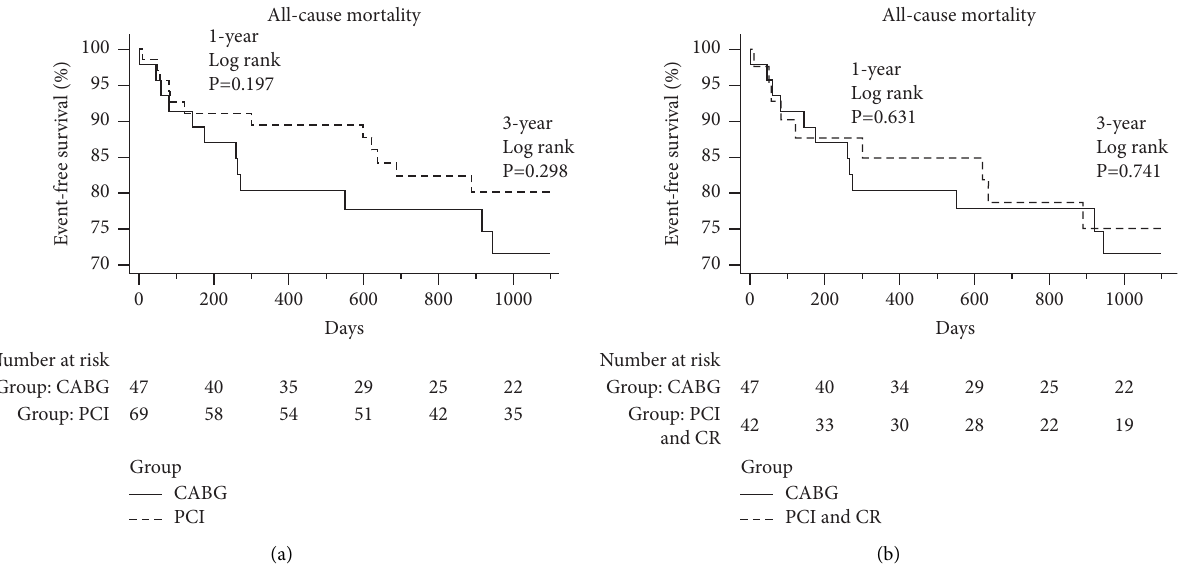
Figure 2: Kaplan–Meier curves of 1- and 3-yearall-cause mortality rates between the groups. (a) Te Kaplan–Meier curve of the 1- and 3- yearall-cause mortality rates between CABG and in all patients in the PCI group and (b) the Kaplan–Meier curve of the 1- and 3-yearall- cause mortality rates between the CABG and the complete revascularization subgroup.